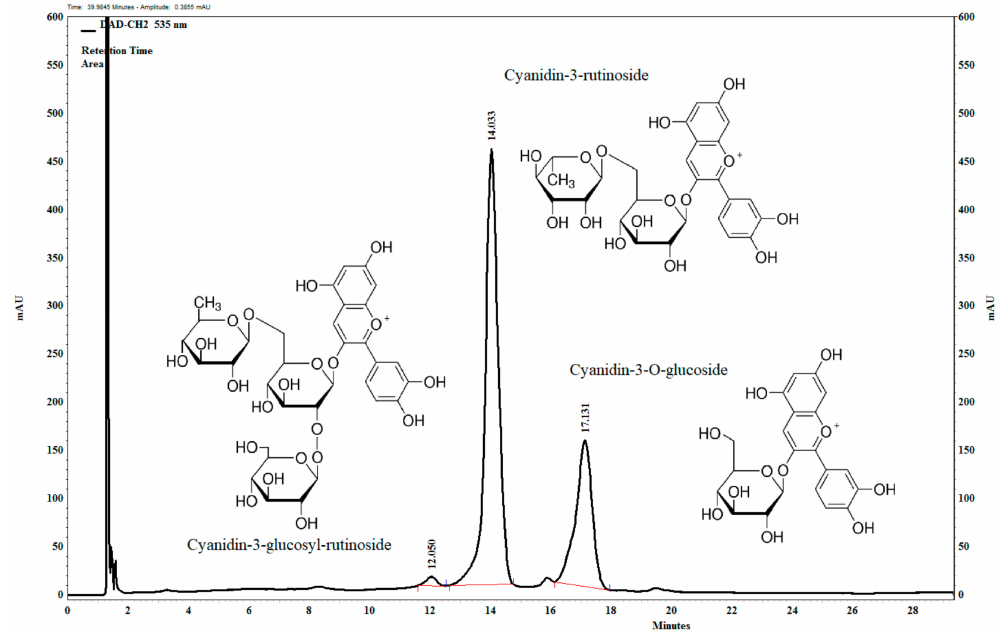
Figure 1. UHPLC chromatogram of the anthocyanin-rich tart cherry extract at 535 nm. Confirmed by the standard.